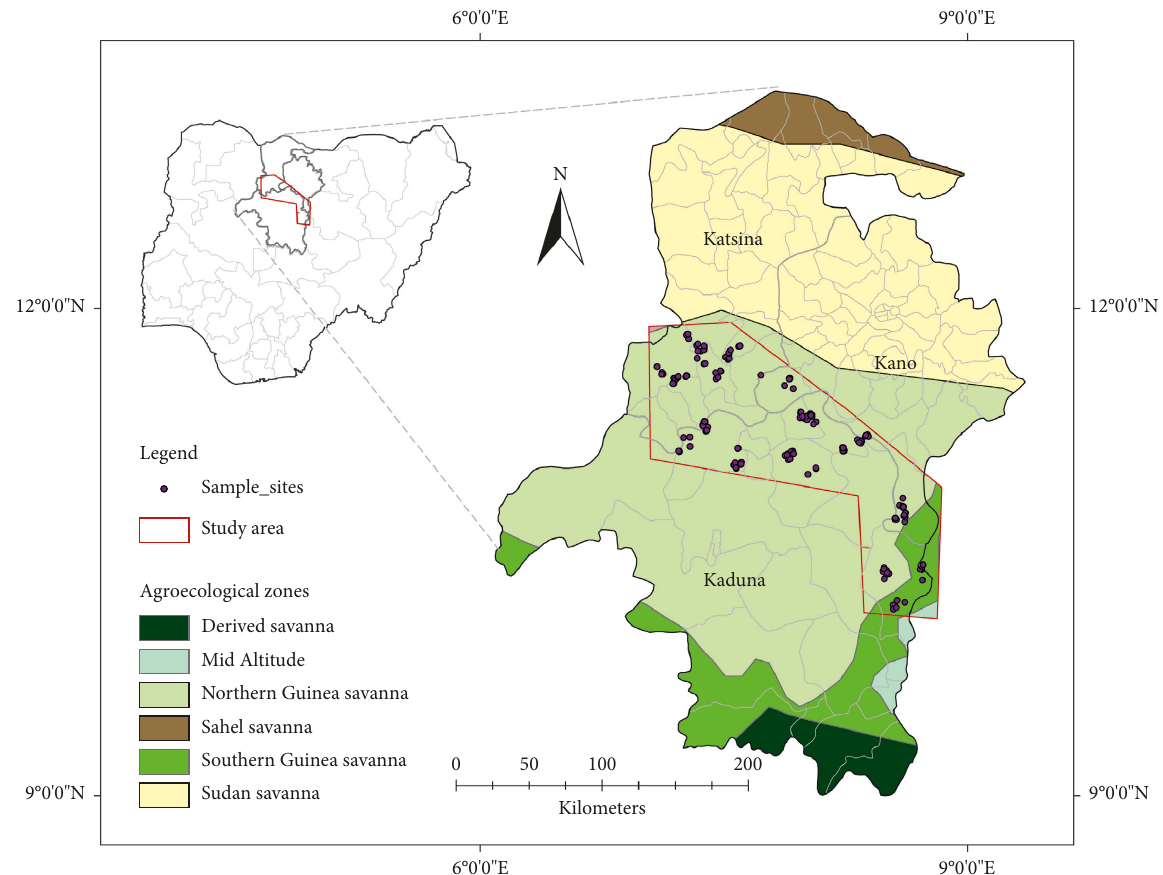
Figure 1: Map showing study location and sampling sites of